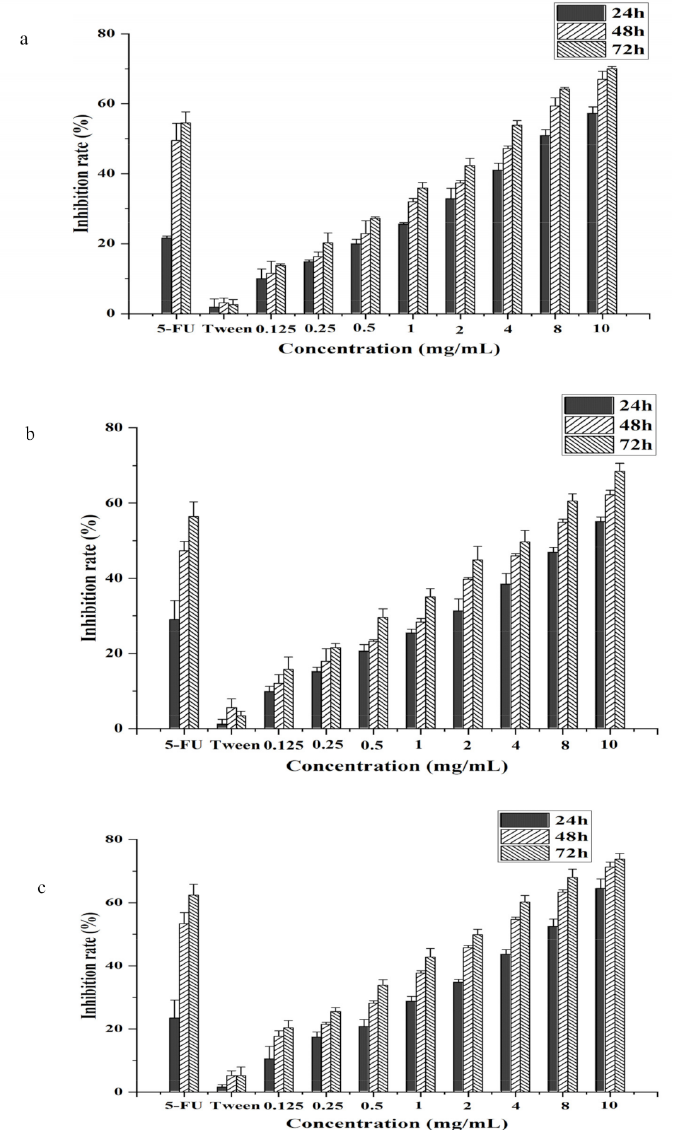
Figure 2. ( a ) Effect of CSO on Caco-2 cells. ( b ) Effect of CSO on HCT-116 cells. ( c ) Effect of CSO on HT-29